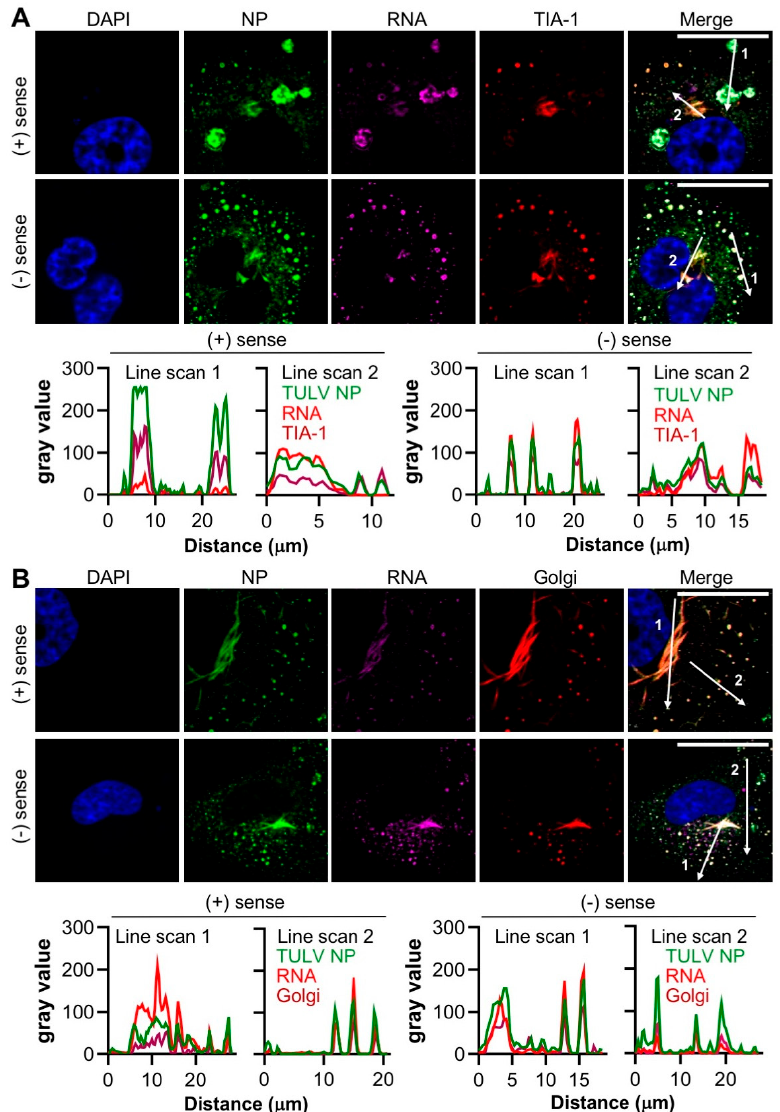
Figure 7. Co-localisation between the TULV NP, the TULV S segment positive and the negative sense RNAs and host cell components TIA-1 and the Golgi marker in Vero E6 cells at 30 days post infection. The spatial distribution of the TULV NP (green), the S segment RNA (magenta) and the host cell markers ( A ) TIA-1, or ( B ) Golgi (both red) were observed during the persistent infections using confocal microscopy at 40 × magnification. Fluorescent line scans were taken using Fiji software with designated number labels corresponding to the adjacent line scan plots. The nuclei were stained with DAPI (blue), TULV NP was detected using NP antisera, with TIA-1 and Golgi detected using specific antisera. Scale bar represents 30 µ m. TULV NP was detected using NP antisera, and S segment RNAs were detected using separate sets of positive sense or negative-sense RNA FISH probes. Images shown in panels A and B show a representative analysis of 8 and 20 cells,